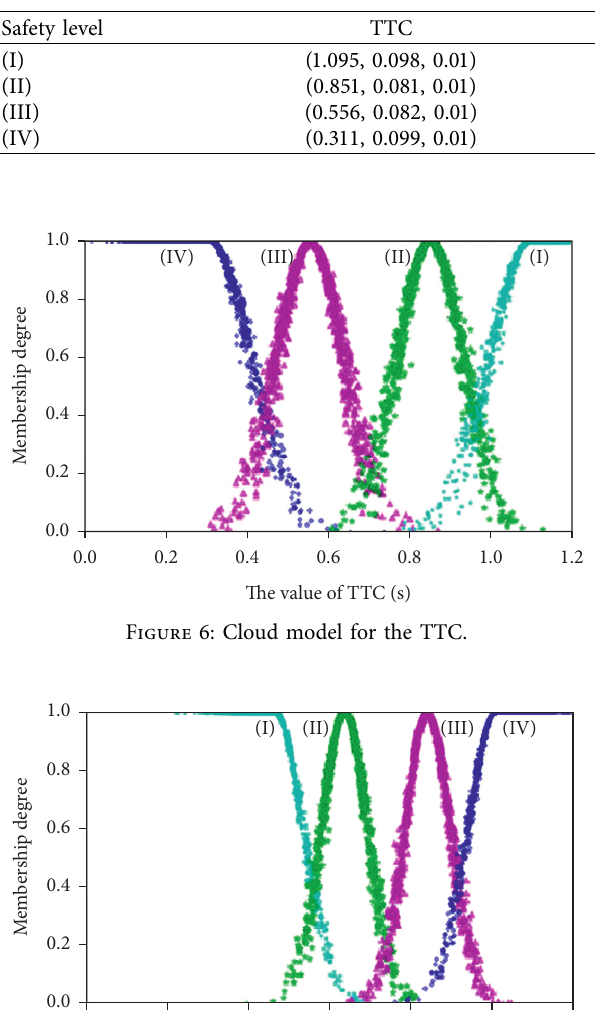
Table 2: Digital features ( Ex , En , He ) of cloud model of the evaluation indicators.